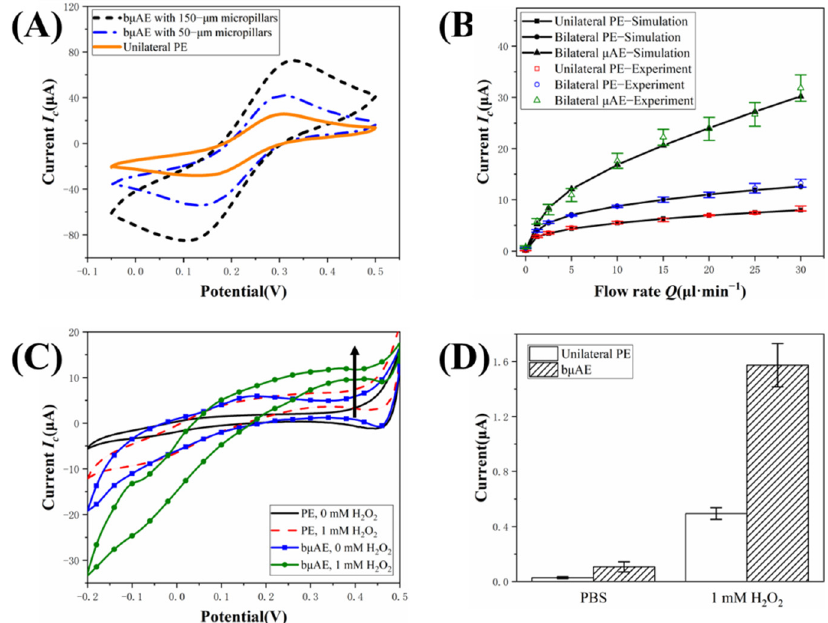
Figure 8. ( A ) CV of the unilateral planar electrode, the bµAE with 50 − µm micropillars and 150 − µm micropillars in the solution containing 5 mM K 3 [Fe(CN) 6 ]/K 4 [Fe(CN) 6 ] and 0.1 M KCl.; ( B ) Experimental and simulated current response of the unilateral planar electrode, the bilateral planar electrode and the bµAE with 150 − µm micropillar at different flow rates. ( C ) CV of the unilateral planar electrode and the bµAE with 150 − µm micropillars at different H 2 O 2 concentrations. ( D ) Comparison of current response between the planar and the bµAE with 150 − µm micropillars toward different H 2 O 2 concentrations when the flow rate is 1 µL·min − 1 .